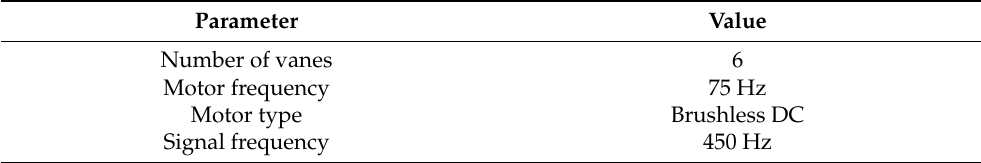
Table 1. Field mill sensor parameters.